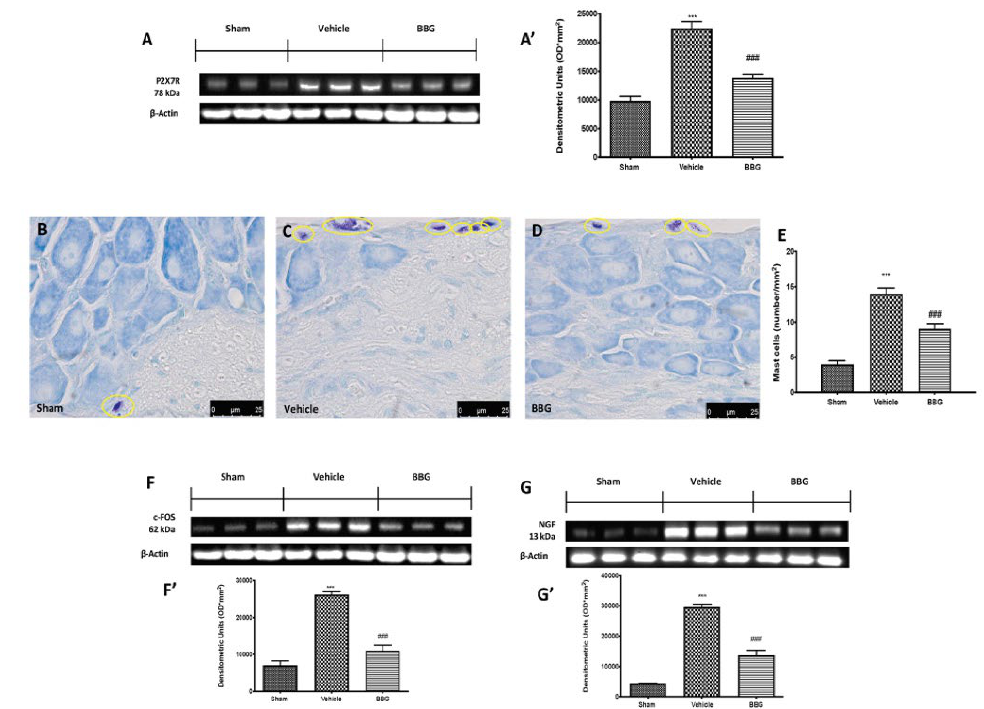
Figure 1. Western blot and respective quantification of P2X7R ( A , A’ ), c-FOS ( F , F’ ) and NGF ( G , G’ ). Evaluation of mast cell degranulation: sham ( B ), vehicle ( C ), BBG ( D ). Mast cell density (mast cell numbers per unit area of tissue; ( E ). Data are representative of at least three independent experiments and are expressed as mean ± SEM from N = 6 rats/group. *** p < 0.001 vs. sham; ### p < 0.001 vs. vehicle.